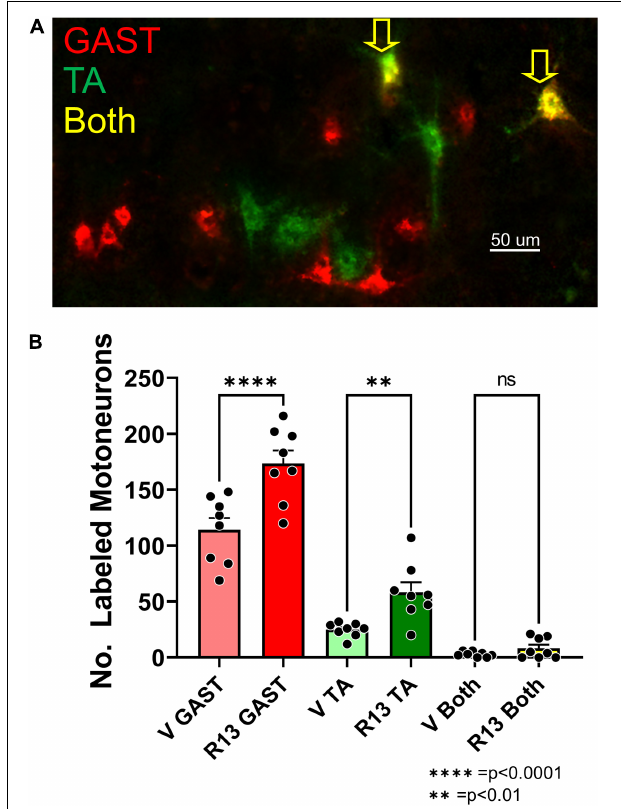
FIGURE 2 | Oral R13 treatments enhance the number of motoneurons whose axons regenerated successfully. A. Image of a longitudinal section through lamina IX of the lumbar spinal cord of a mouse 4 weeks after sciatic nerve transection and repair and treatment with R13. Red and green fluorophores mark motoneurons retrogradely labeled from tracers injected into the reinnervated gastrocnemius (GAST) and tibialis anterior (TA) muscles, respectively. (A) Small number of motoneurons contain both labels (Both, yellow arrows). (B) Mean ( ± SEM, n = 8) numbers of labeled neurons in these three categories in vehicle-treated (V) and R13-treated mice. ** = p < 0.01, **** = p <